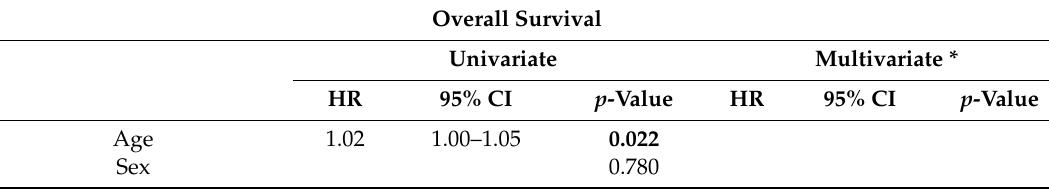
Figure 1. Survival outcomes for a cohort of 402 patients comparing outcomes with or without RPLN involvement. Kaplan–Meier curves for ( A ) overall survival, ( B ) local (primary tumour) progression, ( C ) regional (lymph node) progression and ( D ) distant metastatic progression. RPLN negative (n = 362) in blue and RPLN positive (n = 40) in green. Table 2. Predictors of distant metastases-free survival (DMFS) and overall survival (OS) in the whole cohort (n = 402, including 40 patients with RPLN involvement). Univariate analysis and multivariate Cox proportional hazards analysis using backwards likelihood ratios of established prognostic factors. Factors included in analysis were age, sex, T and N stage, presence of RPLN, use of concurrent chemotherapy and smoking